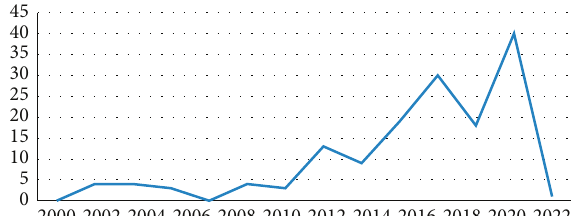
Figure 11: Article distribution by years for systematic search and review